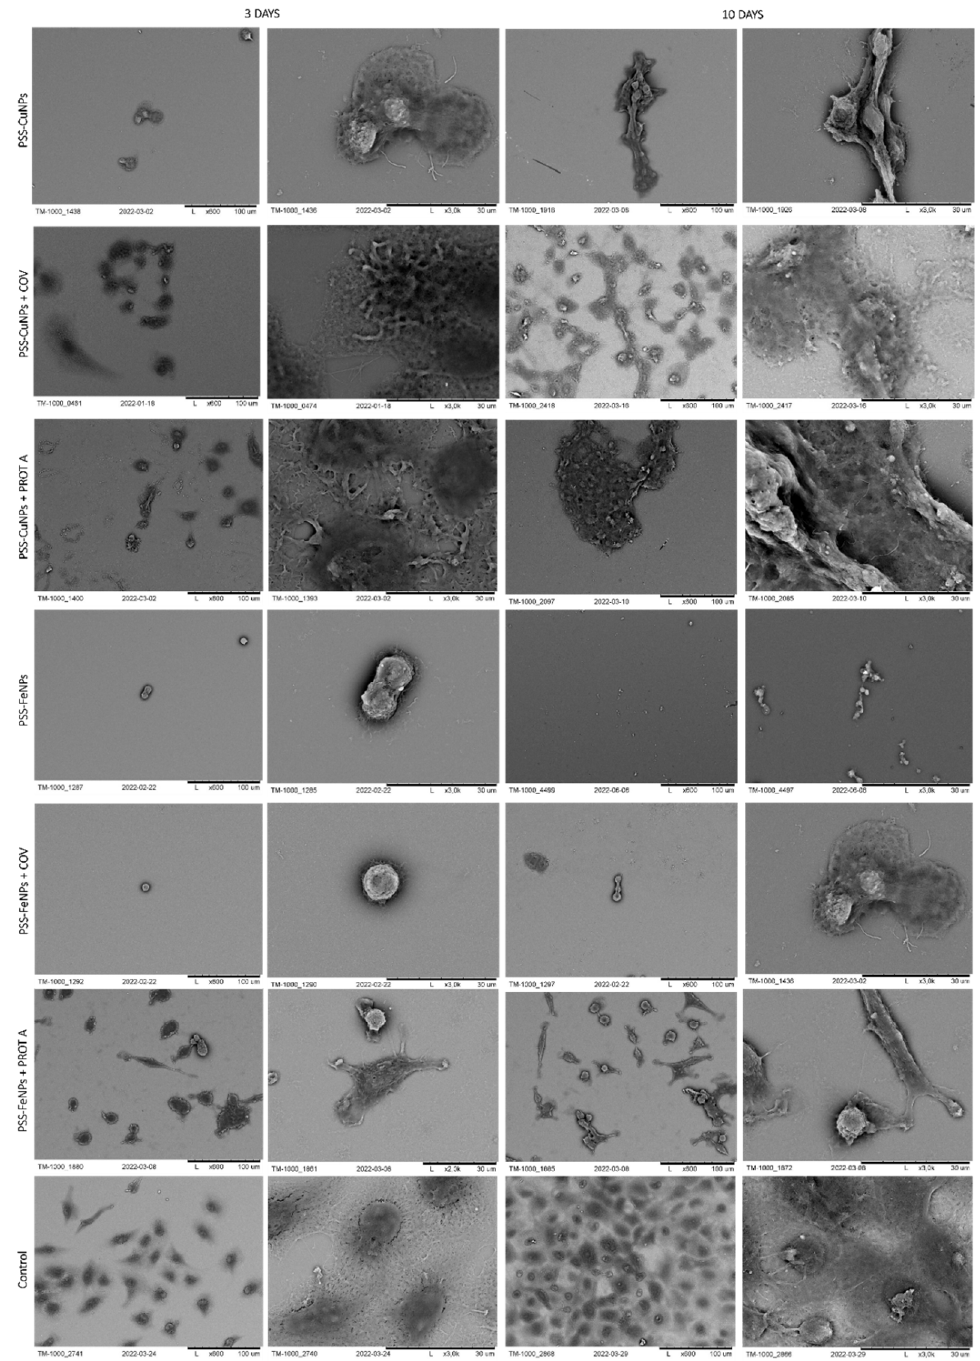
Figure 9. SEM visualization of A549 cells adsorbed within designed membranes after a 3- or 10-day culture. As a control, served cells cultured on glass slides without the membranes. Key to the symbols: PSS-CuNPs: the membrane build of the polystyrene sulfonate with CuNPs incorporated; PSS-CuNPs + COV: the membrane build of the polystyrene sulfonate with incorporated CuNPs with adsorbed COV; PSS-CuNPs + PROT A: the membrane build of the polystyrene sulfonate with CuNPs incorporated with adsorbed Protein A; PSS-FeNPs: the membrane build of the polystyrene sulfonate with FeNPs incorporated; PSS-FeNPs + COV: the membrane build of the polystyrene sulfonate with FeNPs incorporated with adsorbed COV; PSS-FeNPs + PROT A: the membrane build of the polystyrene sulfonate with FeNPs incorporated with adsorbed Protein A.